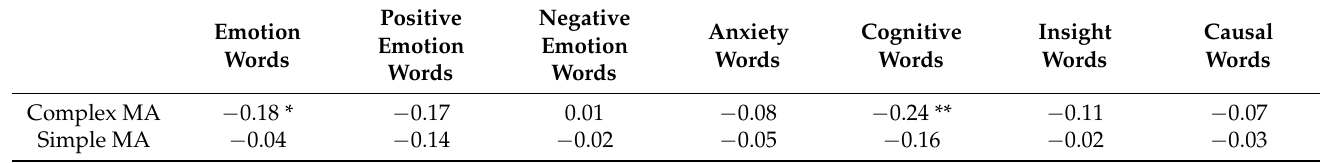
Table 3. Partial correlation analysis of written content and the CUP values of the MA task ( r